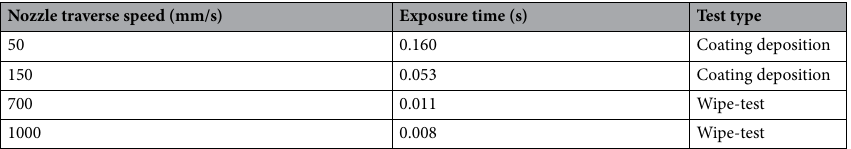
u = 200 ◦ C , t = 5 × 10 − 3 s s with T e s